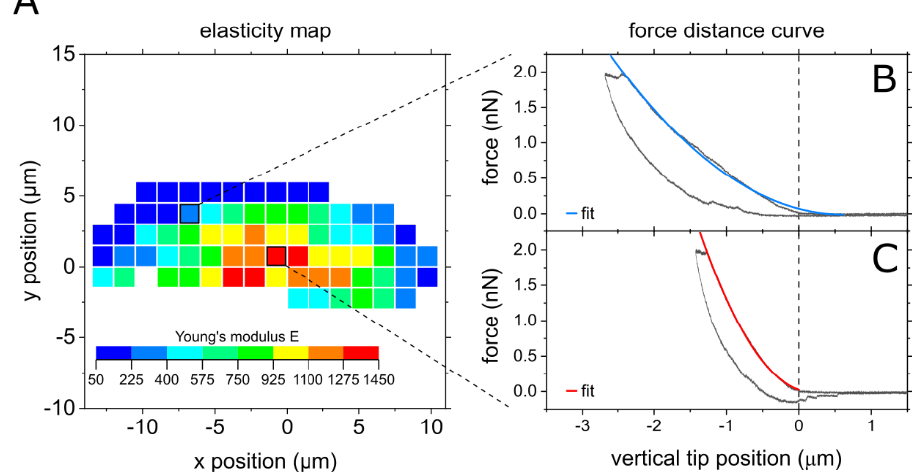
Figure 2. AFM force spectroscopy mapping of a cell using a cantilever with tip. ( A ) Map of half a cell, measurement started at the center of the cell. ( B ) Typical force distance curve from the softer outer area, ( C ) typical force distance curve from the central, stiffer part.